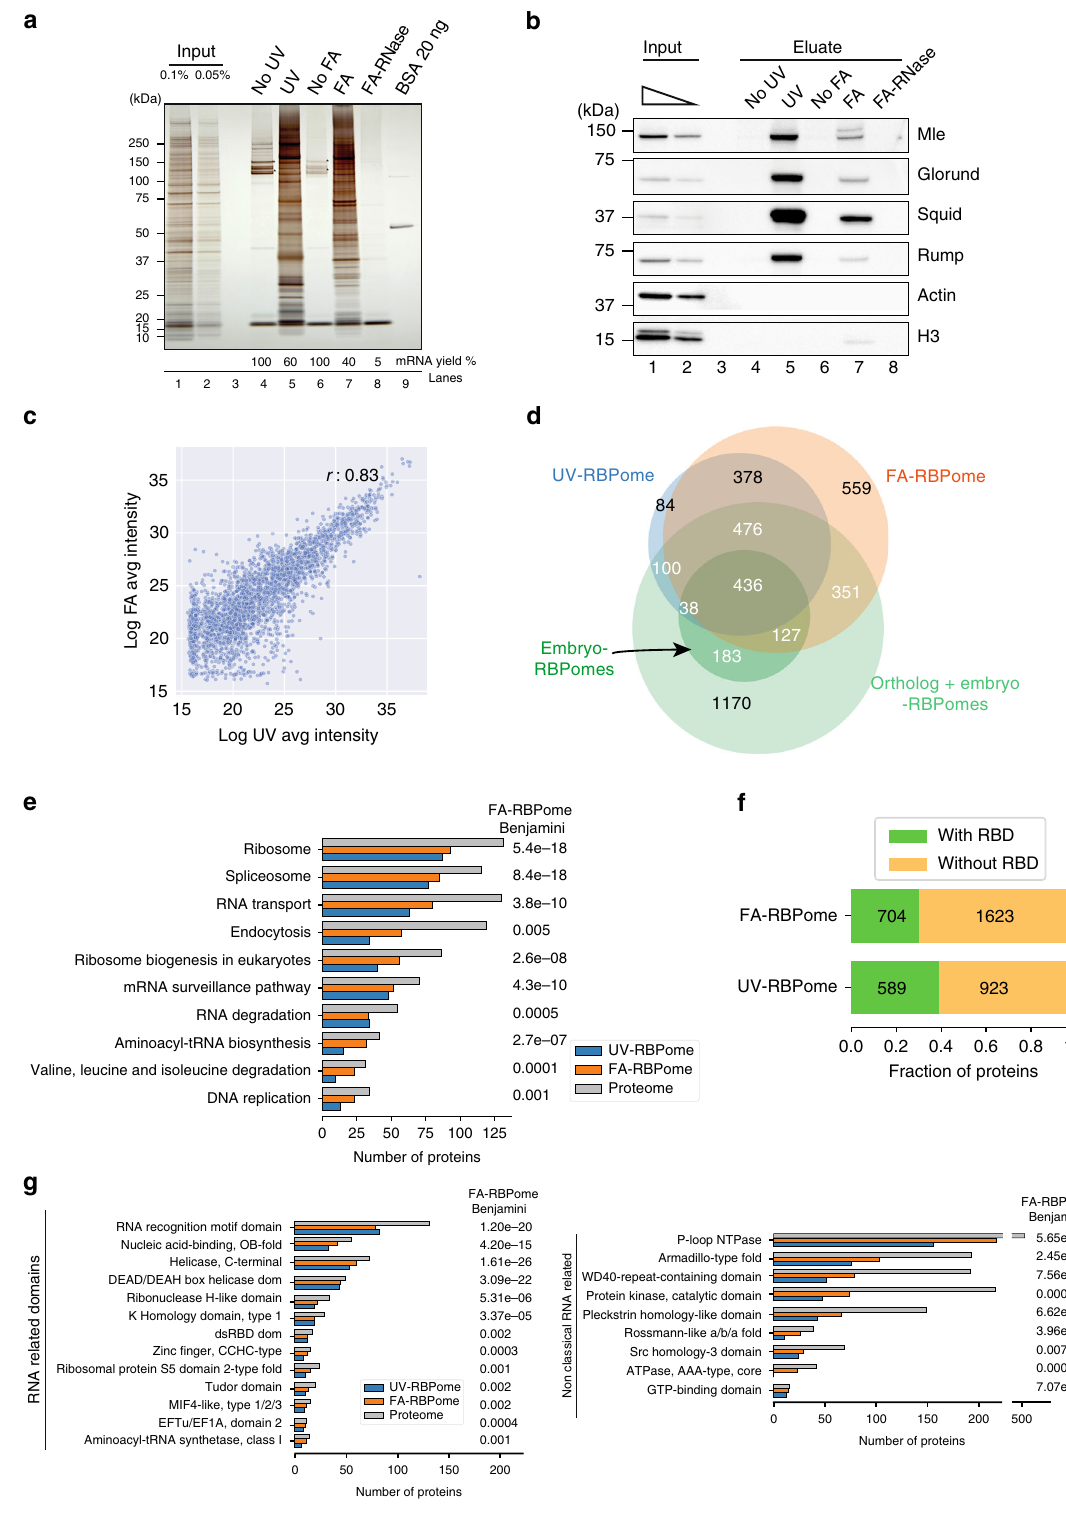
EFTu/EF1A, domain Aminoacyl-tRNA synthetase, class I